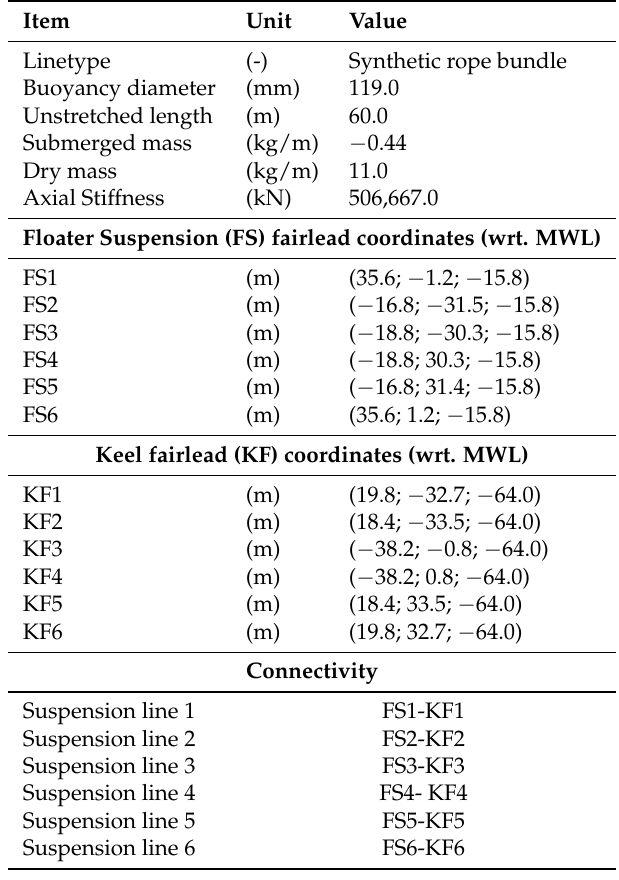
Table 7. Mechanical properties of the suspension lines, with definition of fairlead coordinates and line